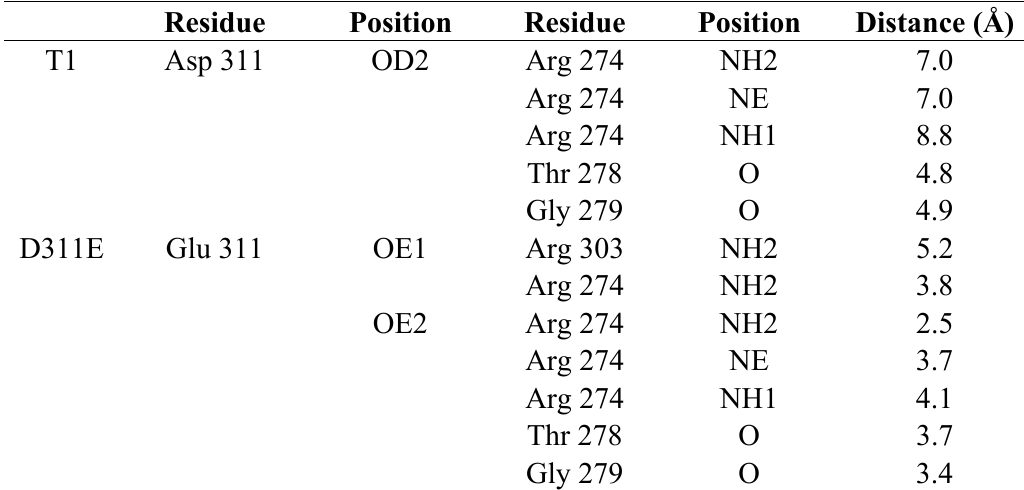
Table 5. The number of charged residues involved in ion pairs of T1 lipase and D311E